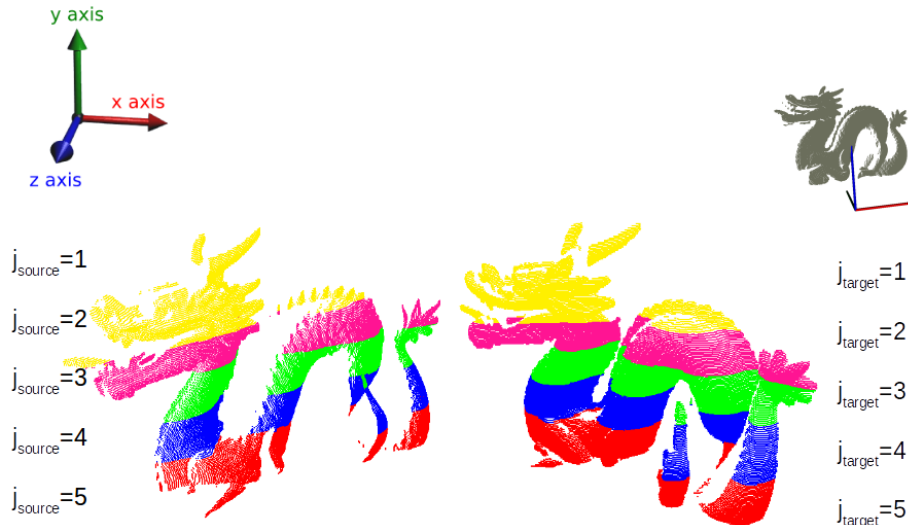
Figure 1. View of top-down partitioning on Dragon